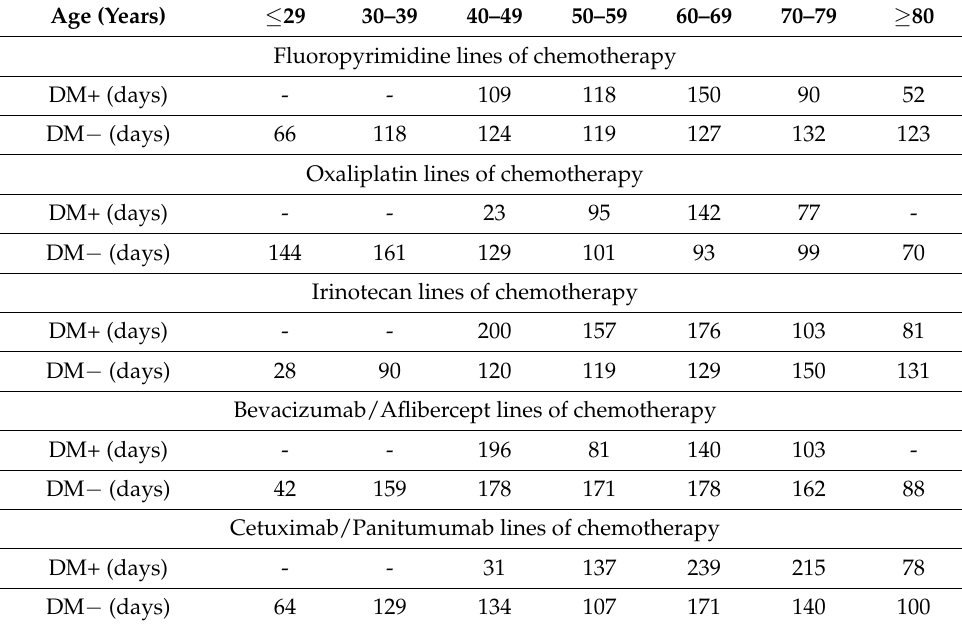
Table 2. TTF average by diabetes presence and age in different lines of